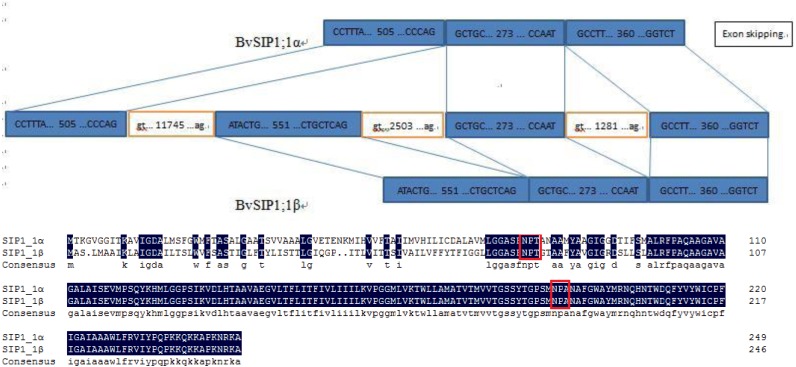
Alternative splicing of SIP1;1 generate two different transcripts: SIP1;1α and SIP1;1β.